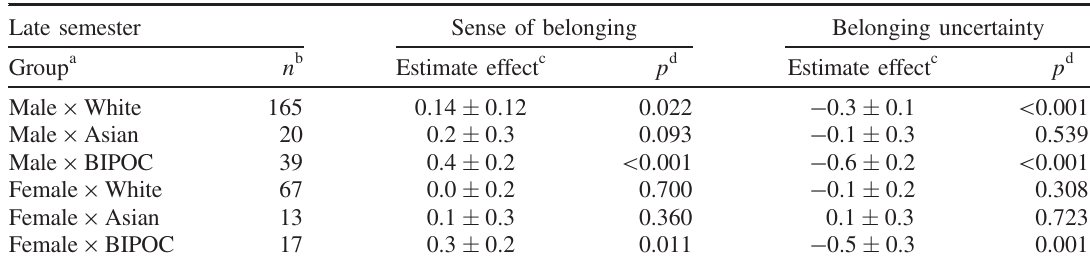
TABLE VII. Marginal effects of midterm performance on late-semester social belonging across sex and race or